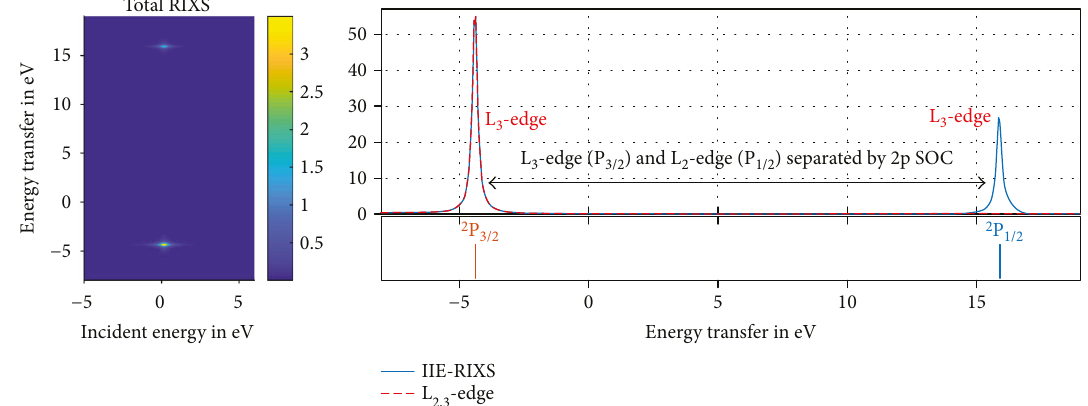
-edge) (dashed red) 2,3